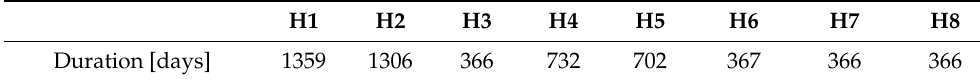
Table 3. Length of available data.